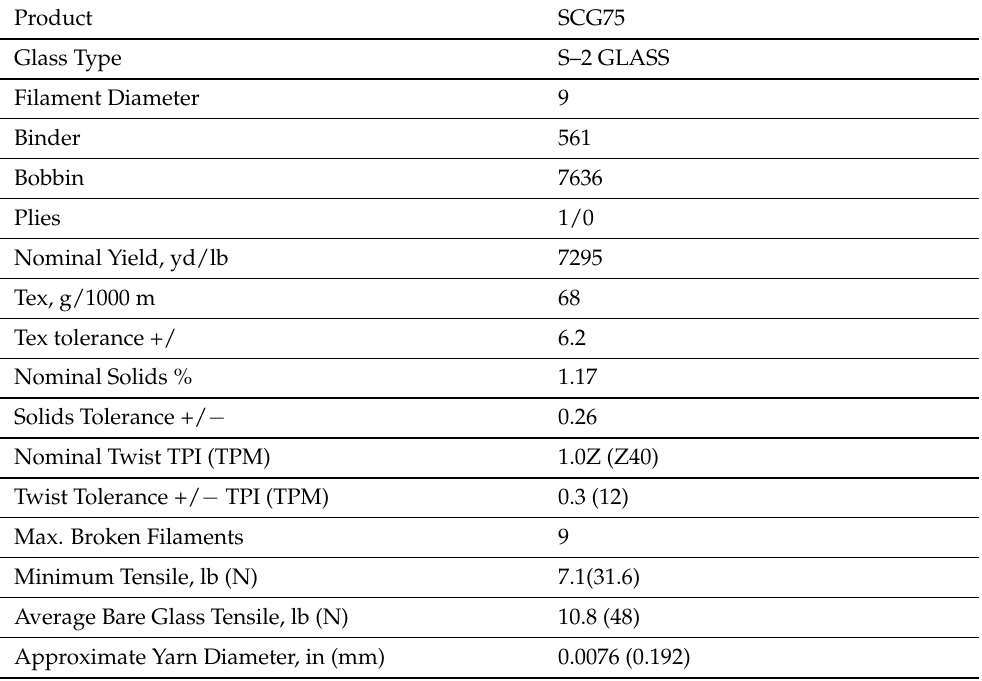
Table 2. S-glass fiber-sized yarns specs [1].